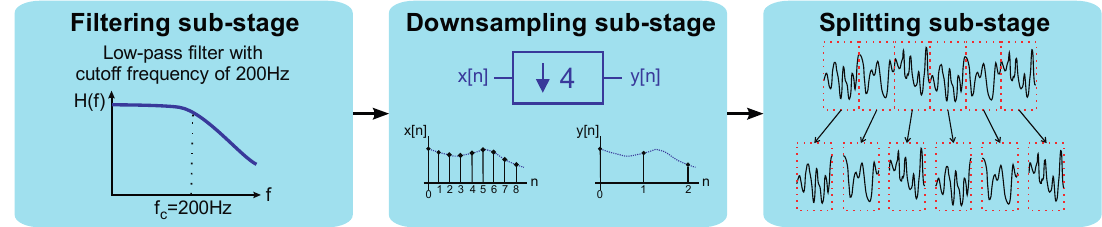
Figure 6. Block diagram representing the three preprocessing